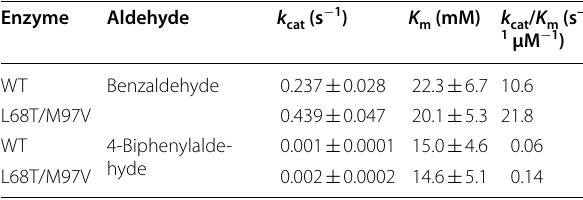
Table 2 Kinetic parameters of Tf NCS and mutant L68T/M97V toward benzaldehyde and